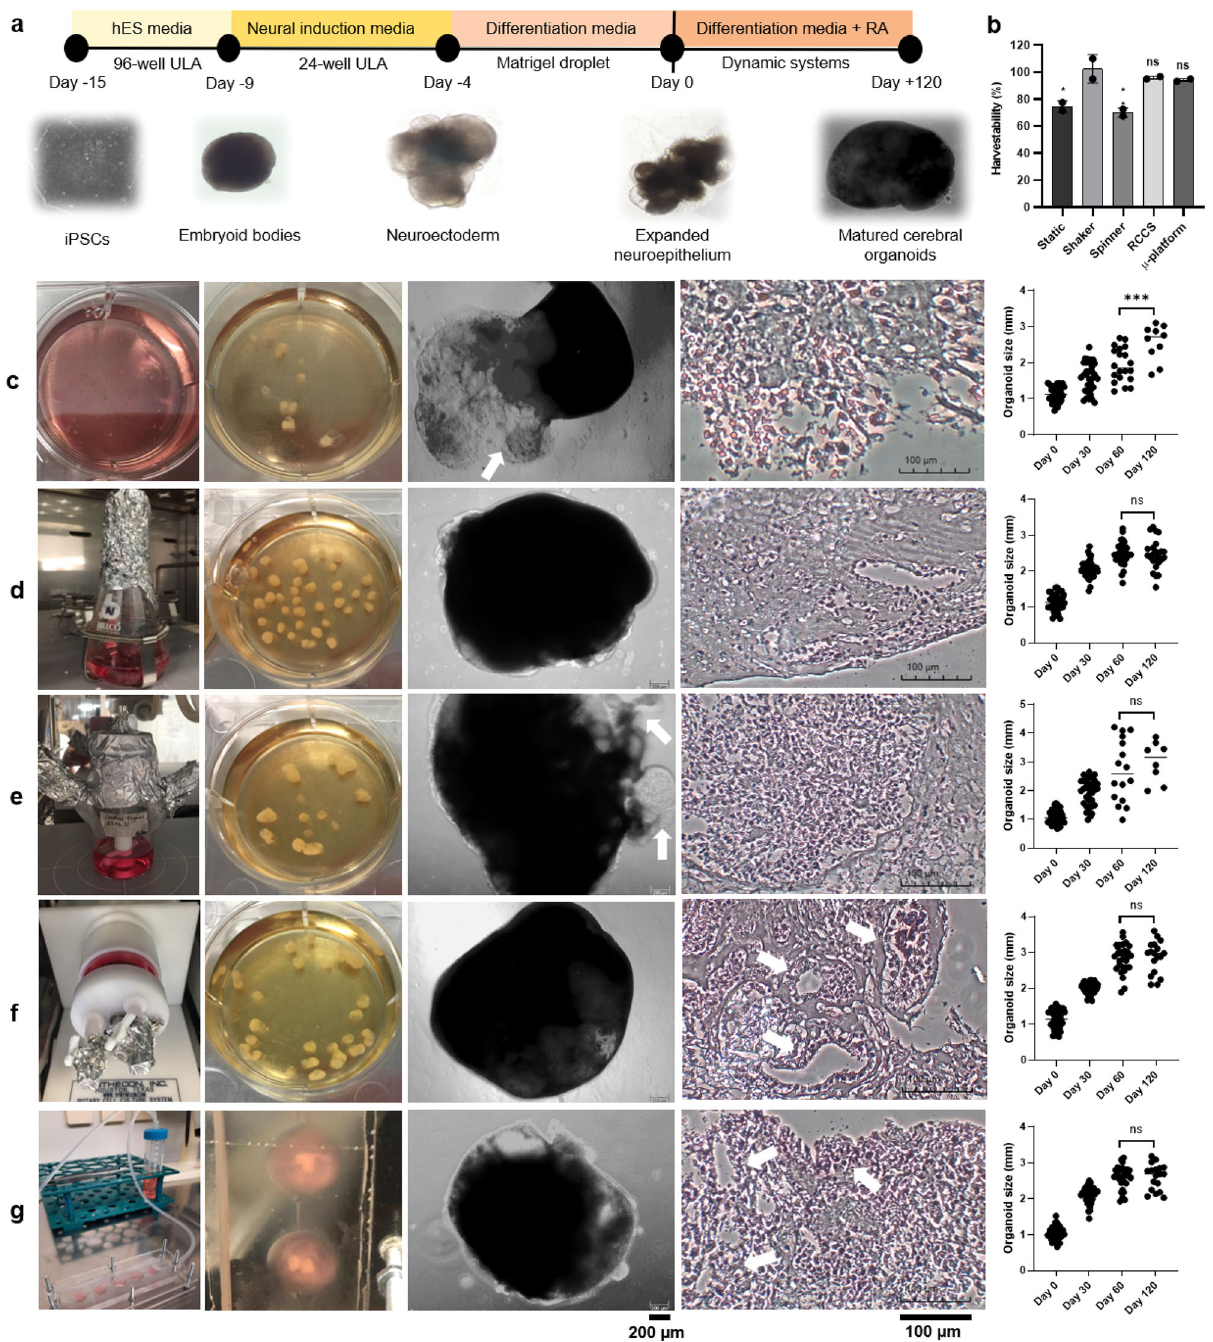
Fig. 2 iPSCs derived cerebral organoid formation process. a Generation steps. b Percentage of organoid harvestability results (shaker versus other systems, * p = 0.0103 for static, ** p = 0.0054 for a spinner, ns; p = 0.5873 for RCCS and ns; p = 0.4343 for µ -platform, n = 2 for independent replicates = 2). Maturation steps by c static and dynamic systems as d shaker, e spinner, f RCCS microgravity bioreactor, and g µ -platform. From left to right, the system overviews, macroscopic images, bright- fi eld microscopic images (white arrows indicate off-target cell differentiation in preserved matrigel matrix) (Zeiss Axio Vert.A1) of organoids and H&E stained (Motic, AE31E) organoids matured in different systems at day 60 (white arrows indicate sequentially organized cell nucleus and neural rosette-like structures) (scale bars = 200 μ m for bright- fi eld and 100 μ m for H&E staining images, independent replicates = 3), and plots of organoid sizes (day 120 versus day 60, *** p = 0.0002 for static, ns; p = 0.9582 for shaker, ns; p = 0.5787 for a spinner, ns; p = 0.9945 for RCCS and ns; p = 0.9918 for µ -platform, independent replicates = 2) where diameters were measured with the ImageJ program at days 0, 30, 60, and 120 ( n = 40, 33, 20, 10 for static, n = 40, 40, 34, 24 for shaker, n = 40, 36, 16, 8 for a spinner, n = 40, 40, 30, 18 for RCCS, and n = 40, 38, 28, 18 for µ -platform, all for on day 0, 30, 60, 120,